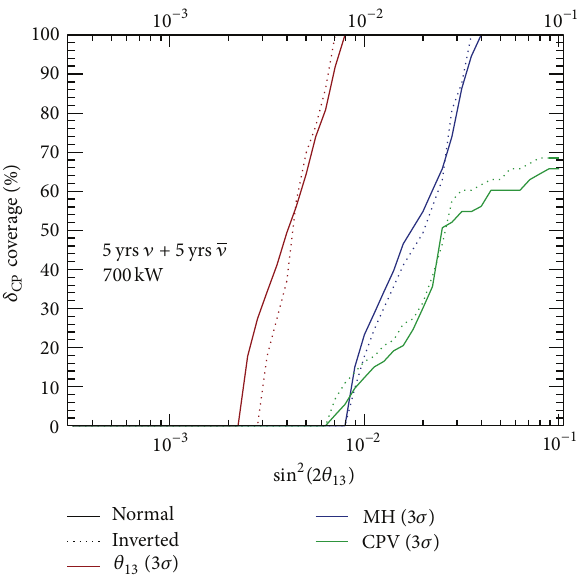
Figure 6: 3 𝜎 discovery potential for determining sin 2 (2𝜃 13 ) ̸= 0 (red), the mass hierarchy (blue), and CP violation (green) as a function of sin 2 (2𝜃 13 ) and the fraction of 𝛿 sensitivitiesareshownforbothnormal(solid)andinverted(dashed) mass hierarchies for a 34 kt LAr detector given five years running in 𝜈 mode + five years in 𝜈 mode in a 700 kW